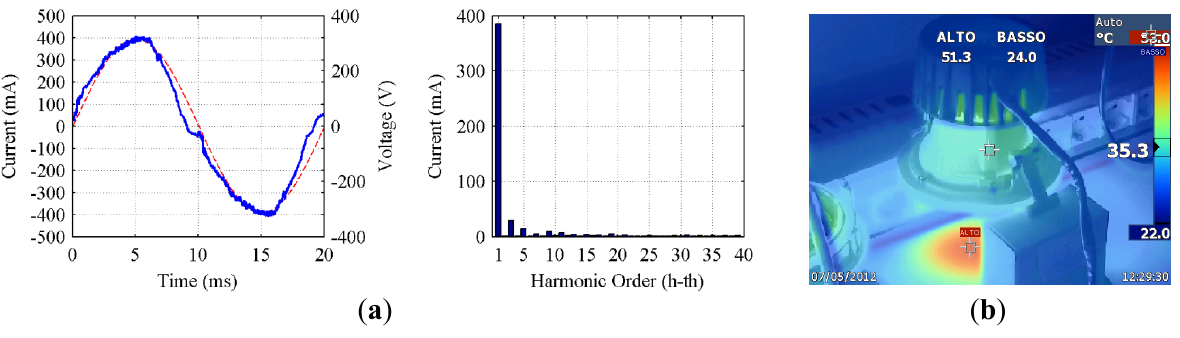
Figure 7. Type B LED spot: ( a ) Current waveform and its spectrum; ( b ) Thermal image.